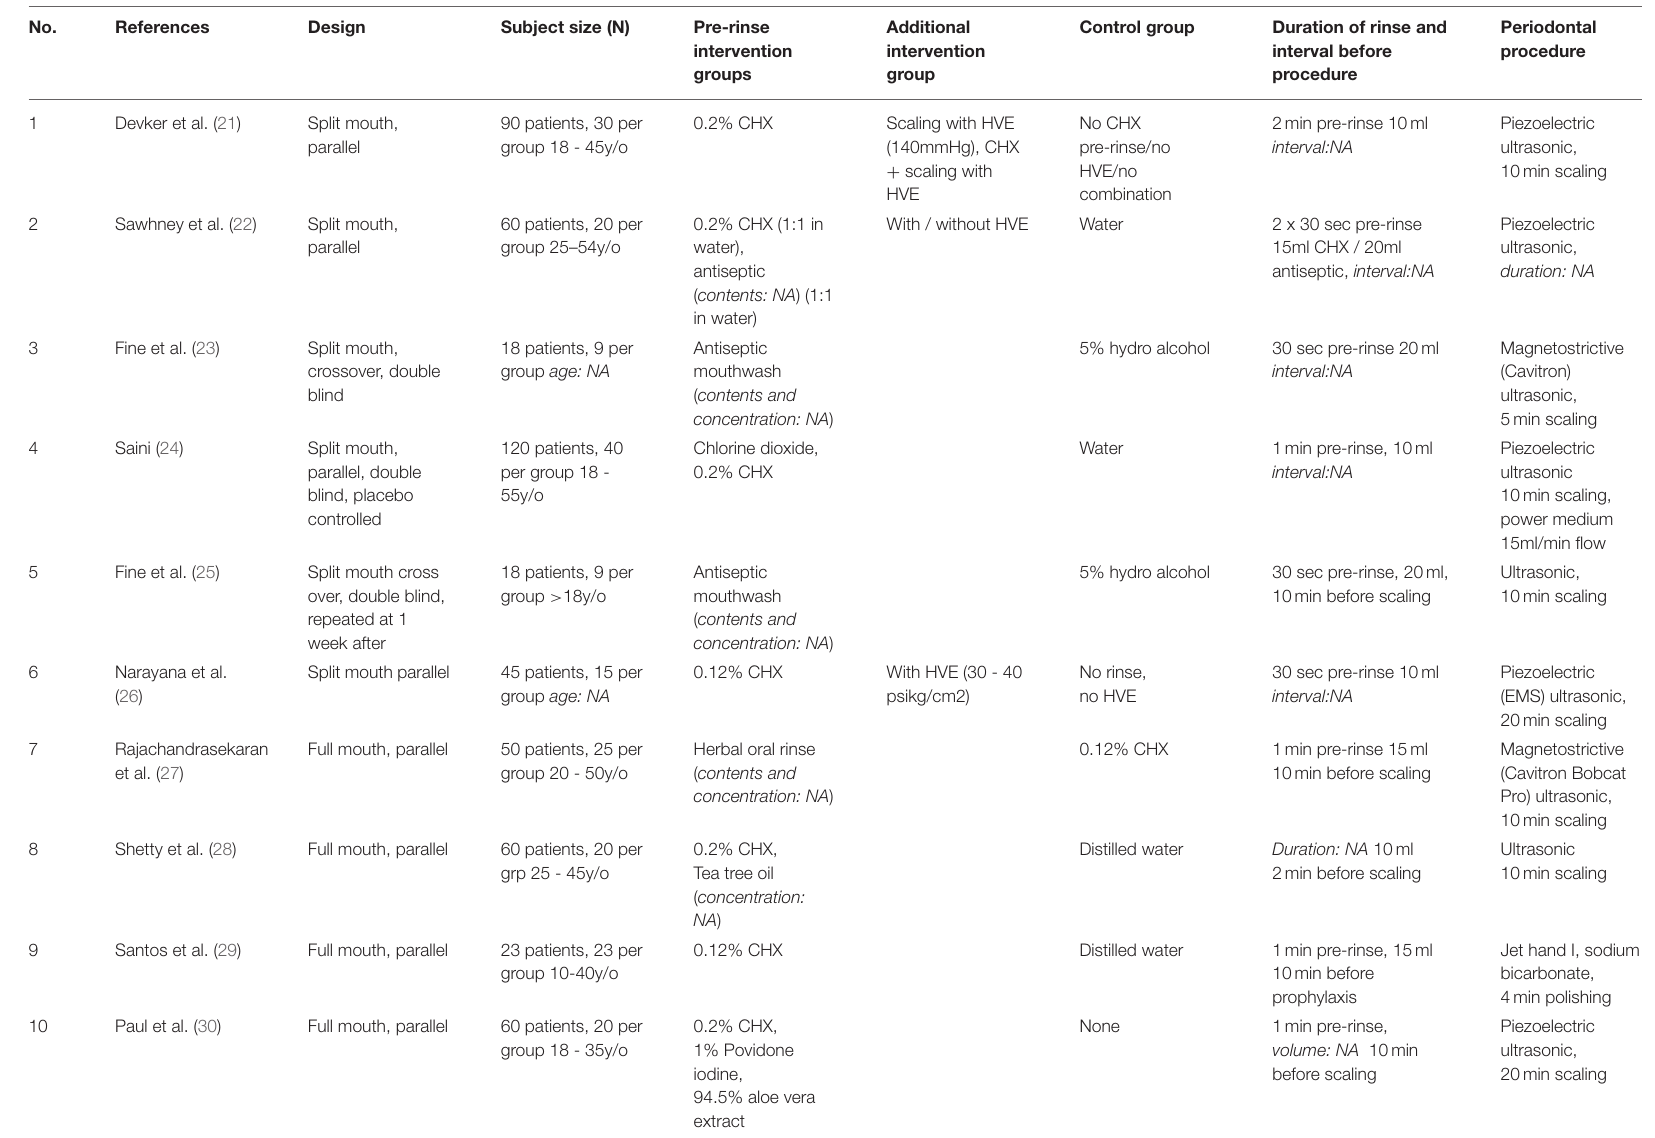
TABLE 1 | Pre-procedural rinse study characteristics